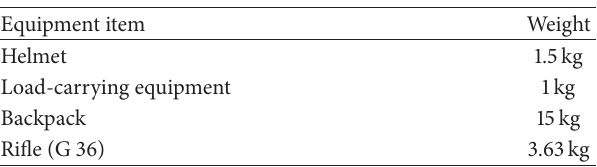
Table 1: Equipment items and